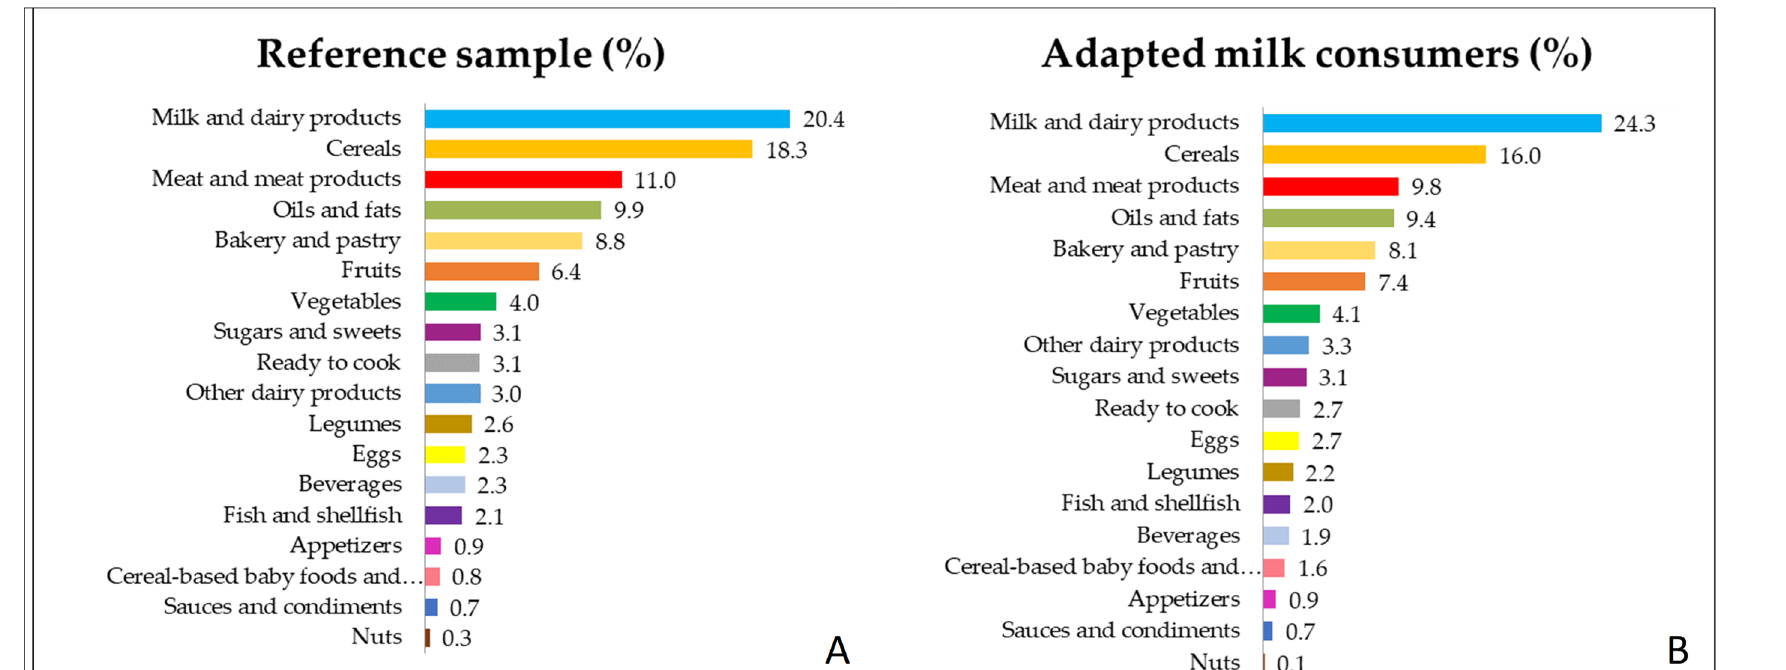
Figure 1. Percentage of the 18 food groups sources of the total energy intake (in %) among Spanish Pediatric Population (EsNuPI) ( A ) shows the reference sample and ( B ) the adapted milk consumers sample. There were statistically significant differences between both samples in the following food groups: Milk and dairy products, Cereals, Meat and meats products, Oils and fats, Fruits, Eggs, Beverages, Legumes, Cereal-based baby foods and Nuts ( p < 0.005).